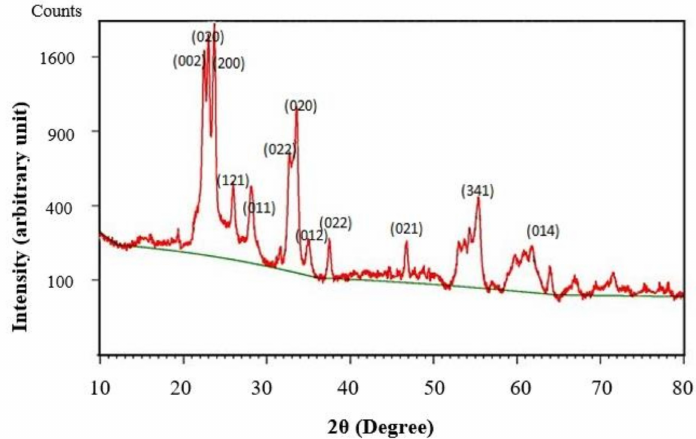
Figure 27. XRD spectrum of PANI/WO 3 /CuCl 2 composite.